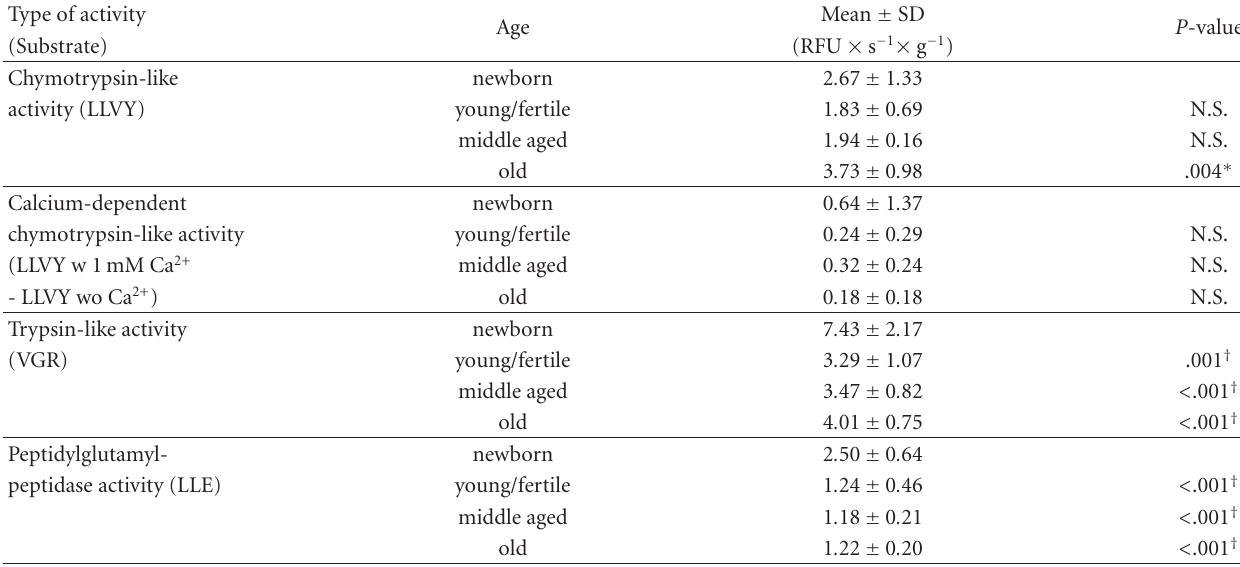
Table 1: Proteasome activity in rat